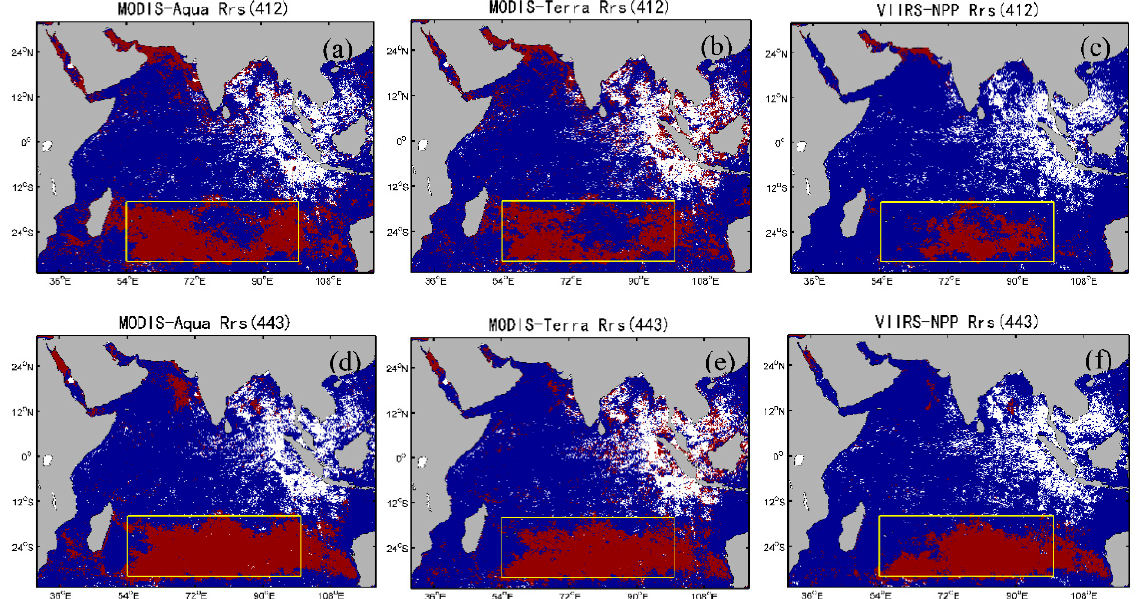
Figure 5. R rs ( λ ) QA scores at blue bands (412 nm and 443 nm) of MODIS − Aqua ( a , d ), MODIS − Terra ( b , e ), and VIIRS − NPP ( c , f ) in October, 2016. The red color represents score of 0 (low − quality data) and blue color represents score of 1 (high quality data). The white color represents invalid pixels. The yellow rectangles roughly outline the location of the oligotrophic gyre zone in the southern Indian Ocean.